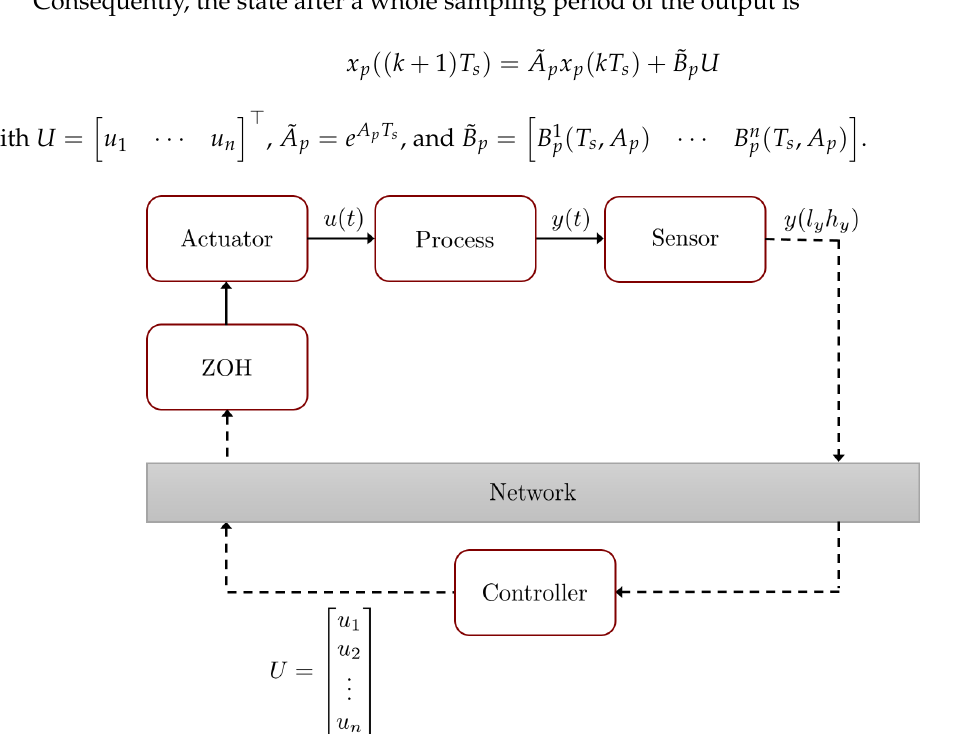
Figure 1. Block diagram of a dual-rate system with fast